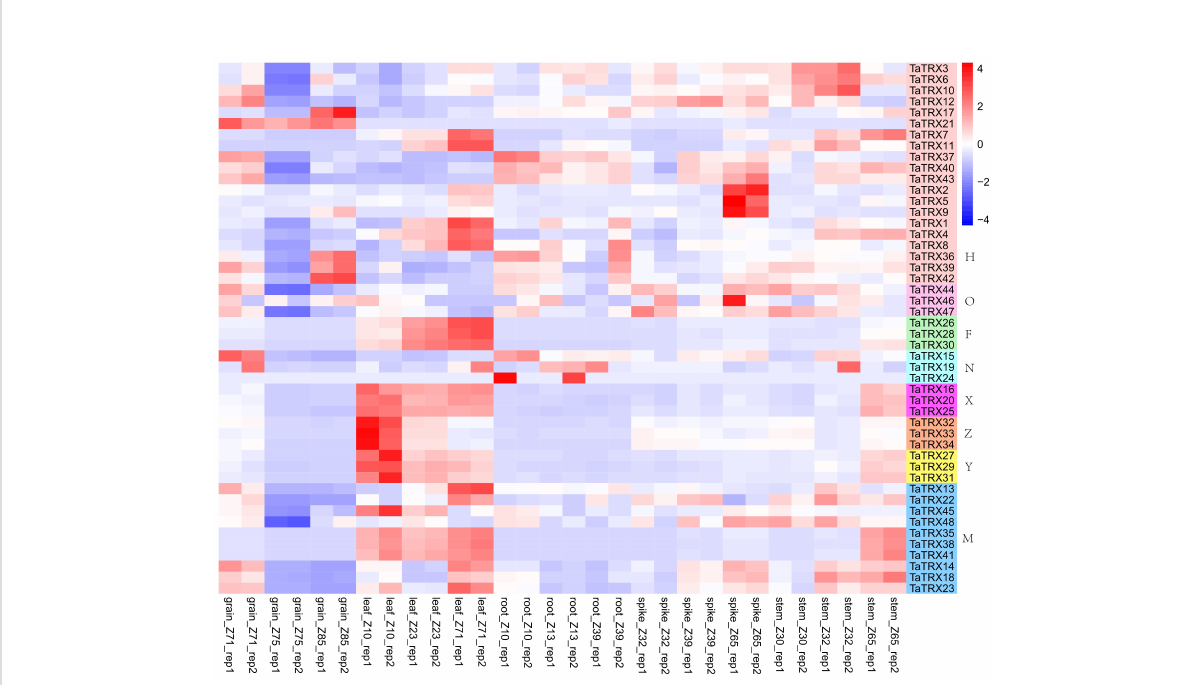
FIGURE 5 Expression pro fi les of typical TaTRX genes in different tissues and organs. grain_Z71, grain_Z75 and grain_Z85 were 2d, 15d and 30d grains after fl owering, respectively. leaf_Z10, leaf_Z23 and leaf_Z71 represent leaf at seedling stage, fl ag leaf at tillering stage and leaf 2d after fl owering, respectively. root_Z10, root_Z13 and root_Z39 represent roots at seedling stage, three-leaf stage and fl ag leaf stage, respectively. spike_Z32, spike_Z39 and spike_Z65 represent the spikes at two-edged stage, fl ag leaf stage and fl owering stage respectively. stem_Z30, stem_Z32 and stem_Z65 were the ear at 1cm length, the ear at two-edged stage and the ear at fl owering stage respectively. The red, white and blue cells represent the highest, medium and lowest gene expression levels, respectively. H, O, F, N, X, Z, Y, and M represent different subtypes of typical TaTRX genes, respectively. The colour scale represents Log2 expression